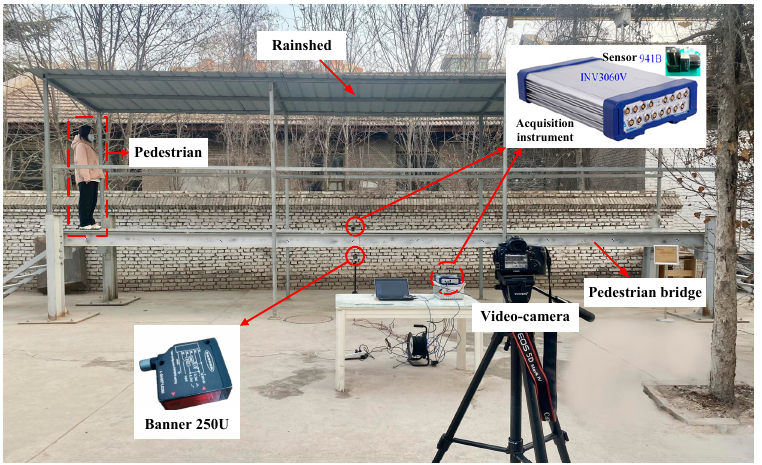
Figure 5. Test site layout.